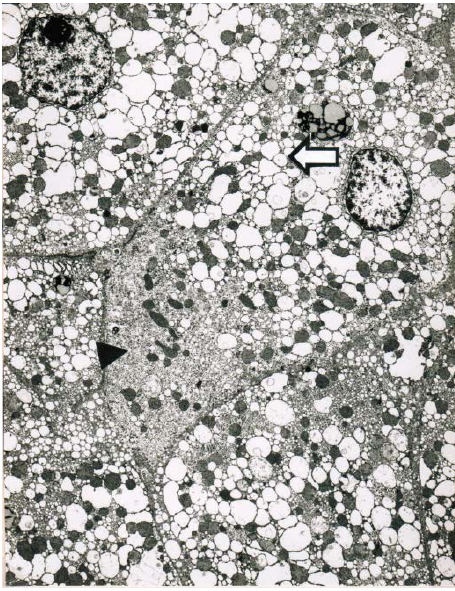
Figure 7. Patient 5 with poisoning by CCl 4 ingestion (50 mL) and liver tissue specimen obtained on day 14 after intoxication for electron microscopy (5200-fold magnification). Key features include a striking proliferation of the smooth endoplasmic reticulum of the hepatocyte ( ► ) with close by injured mitochondria, and in addition to a pronounced dilatation of the smooth endoplasmic reticulum presenting as dilated cisterns ( ).